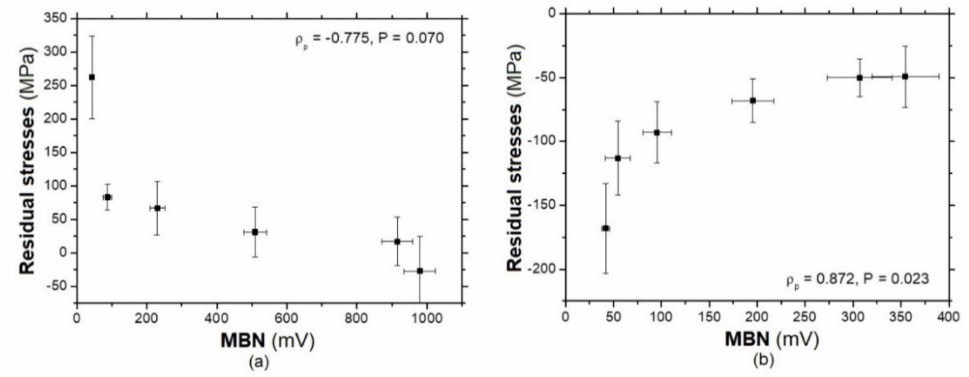
Figure 14. Correlation between residual stresses and MBN. ( a ) 0 ◦ direction, ( b ) 90 ◦ direction.